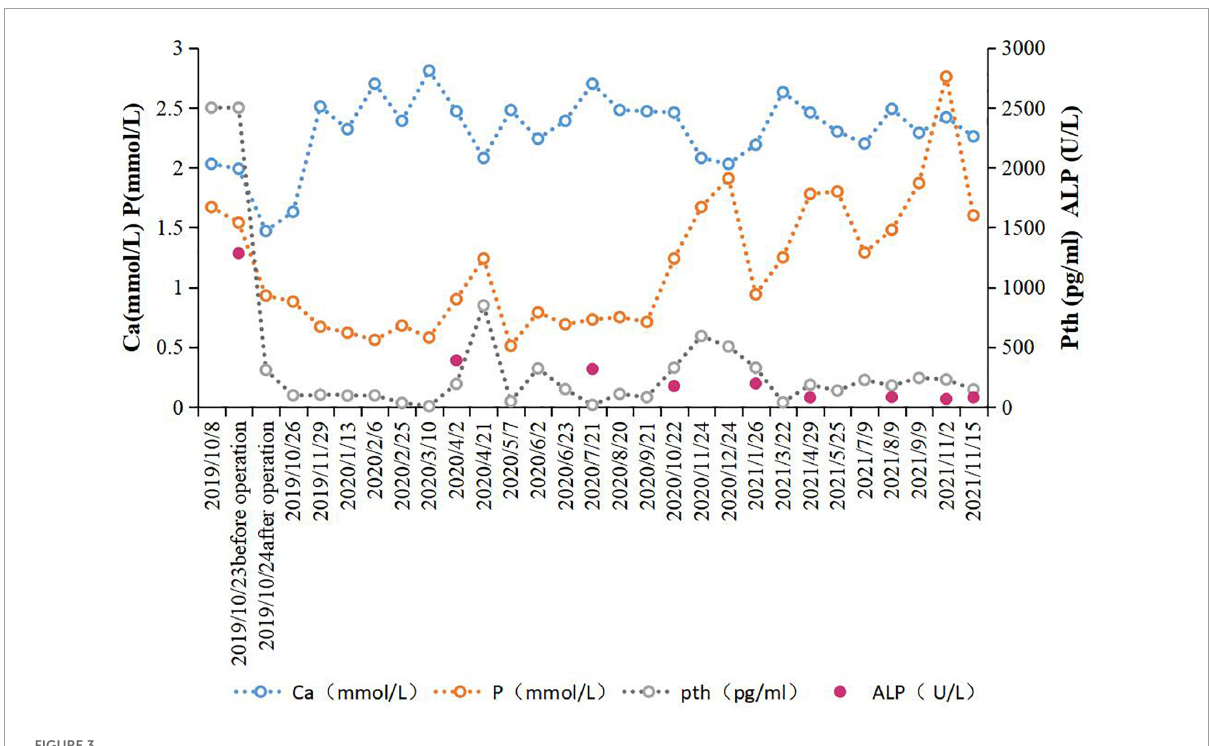
FIGURE3 Relevant clinical test values before and after parathyroid radiofrequency ablation Reference values: Ca (2.11–2.52 mmol/L); P (0.85–1.51 mmol/L); parathyroid hormone (PTH) (12–65 pg/ml); alkaline phosphatase (ALP) (45–125